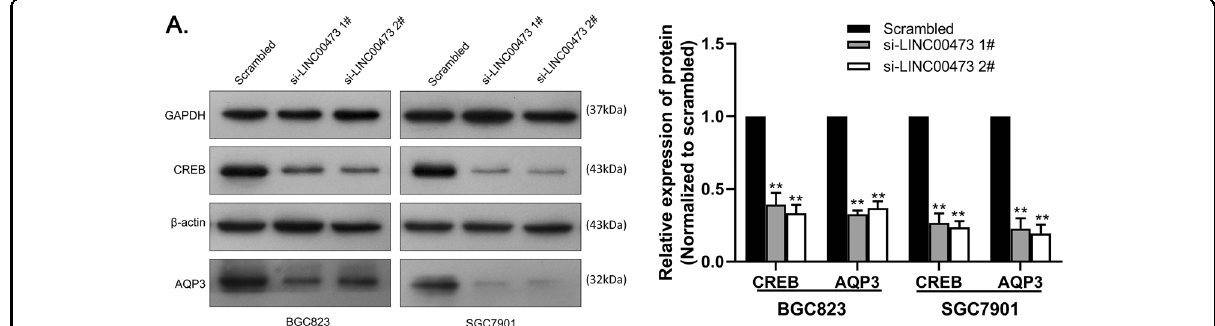
Fig. 8 The protein expression of CREB and AQP3. A The protein expression of CREB and AQP3 was in fl uenced by LINC00473 knockdown. Values are shown as the mean ± SD based on three independent experiments. * P < 0.05, ** P <